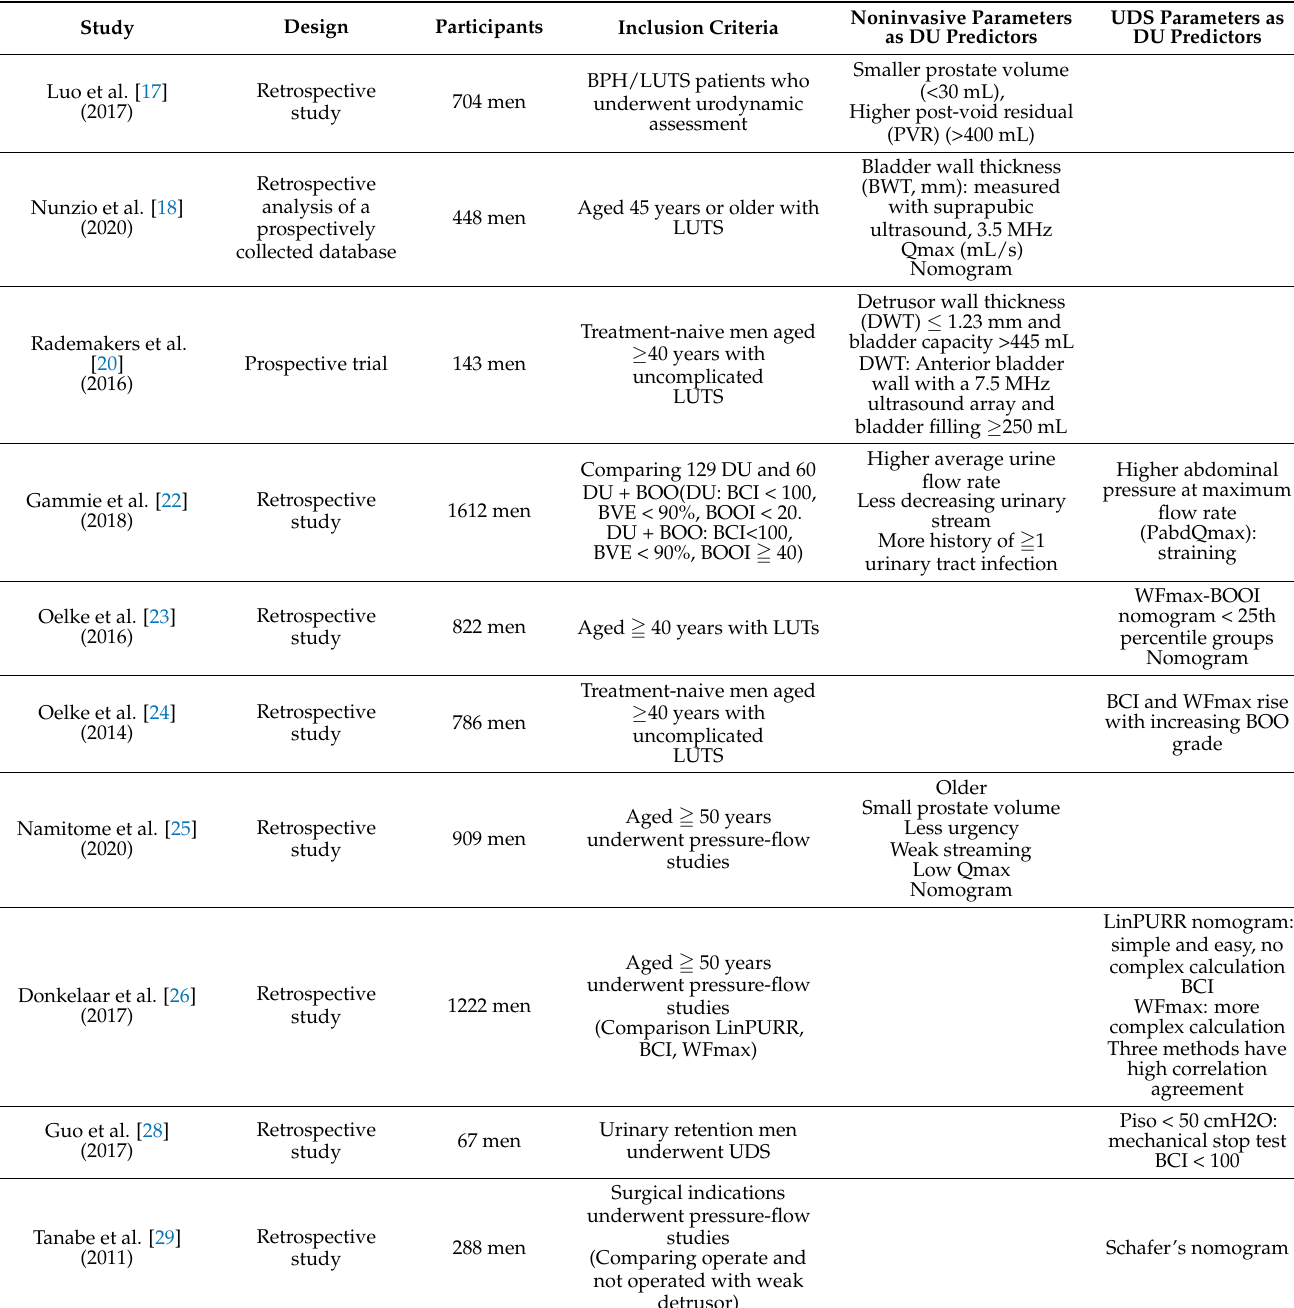
Table 1. Enrolled studies correlate to findings with DU predictors in BOO